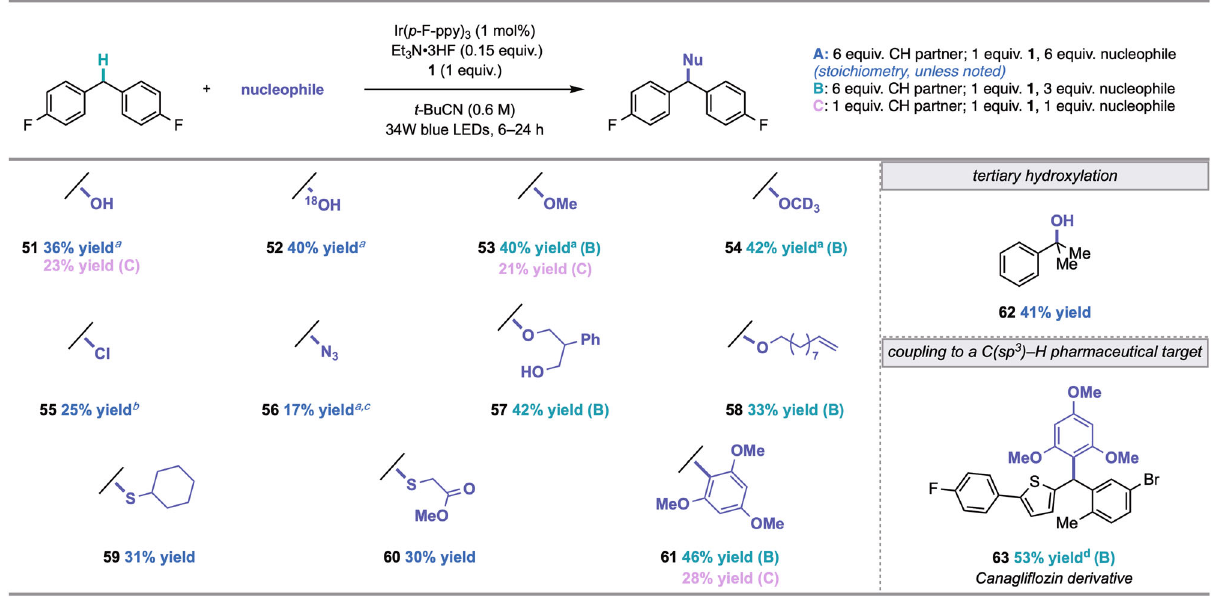
Fig. 4 Scope of general nucleophilic C(sp 3 ) – H functionalization (0.25 mmol, isolated yields). a 19 F NMR yields. b Reaction was performed without Et 3 N • 3HF. c Reaction was performed without Et 3 N • 3HF and with 0.15 equiv. H 2 O. d Reaction performed using Ir( p -CF 3 -ppy) 3 as photocatalyst, benzene as solvent, and 3.0 equiv. C(sp 3 ) – H coupling